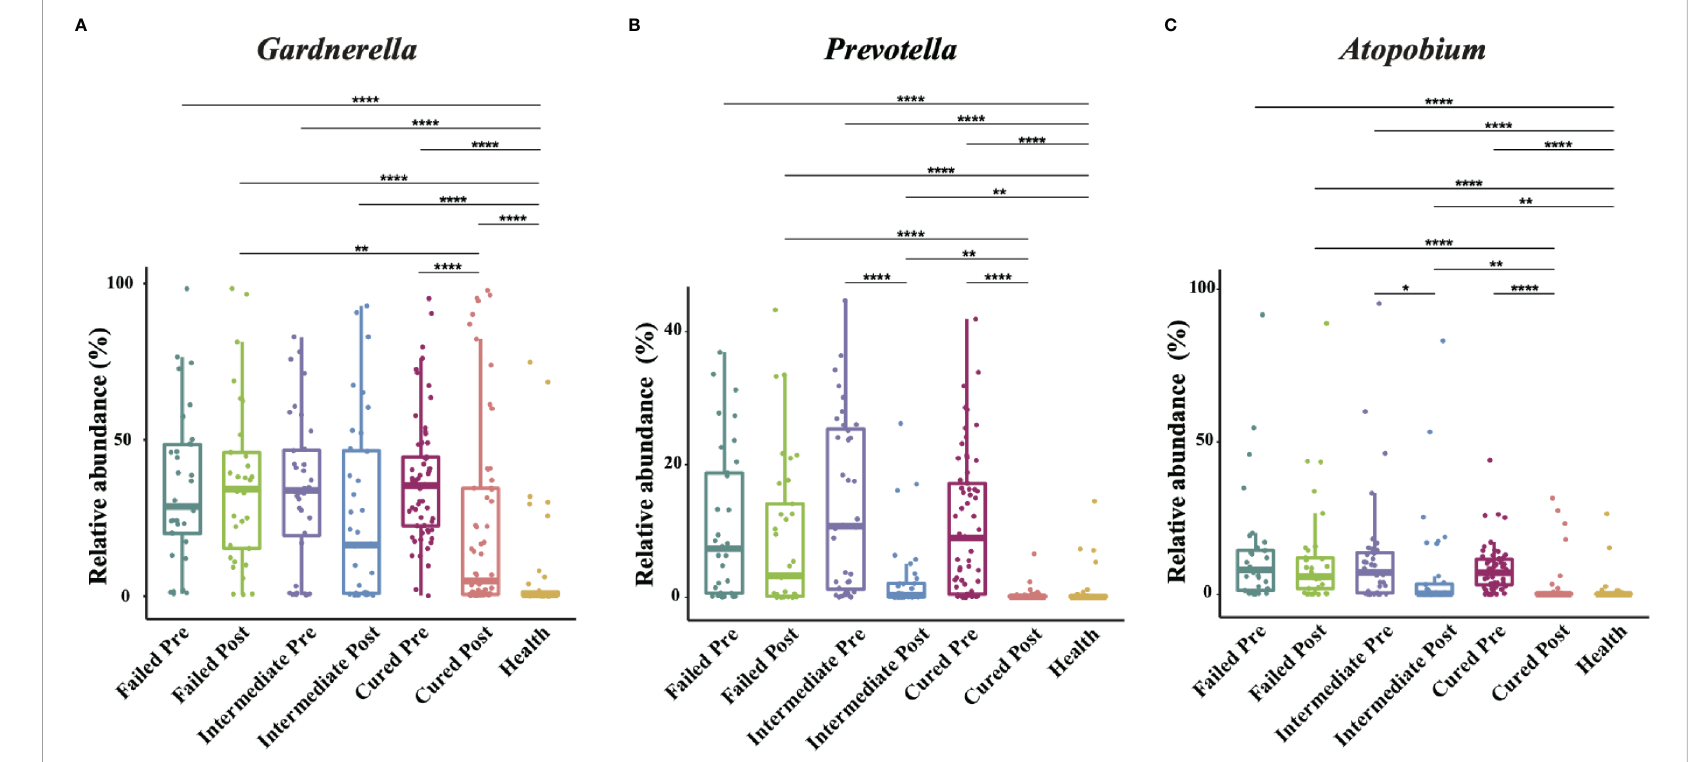
FIGURE 2 Comparison of Gardnerella, Prevotella and Atopobium abundance in different groups. Intergroup comparison of Gardnerella (A) , Prevotella (B) and Atopobium (C) relative abundance. Only statistically signi fi cant P value that has clinical meaning is marked in the graph. Signi fi cance is exhibited as: *: p<0.05; **: p<0.01; ***: p<0.001; ****: p<0.0001; Wilcoxon test for pairwise comparison between pre- and posttreatment and Kruskal-Wallis test for comparisons among different